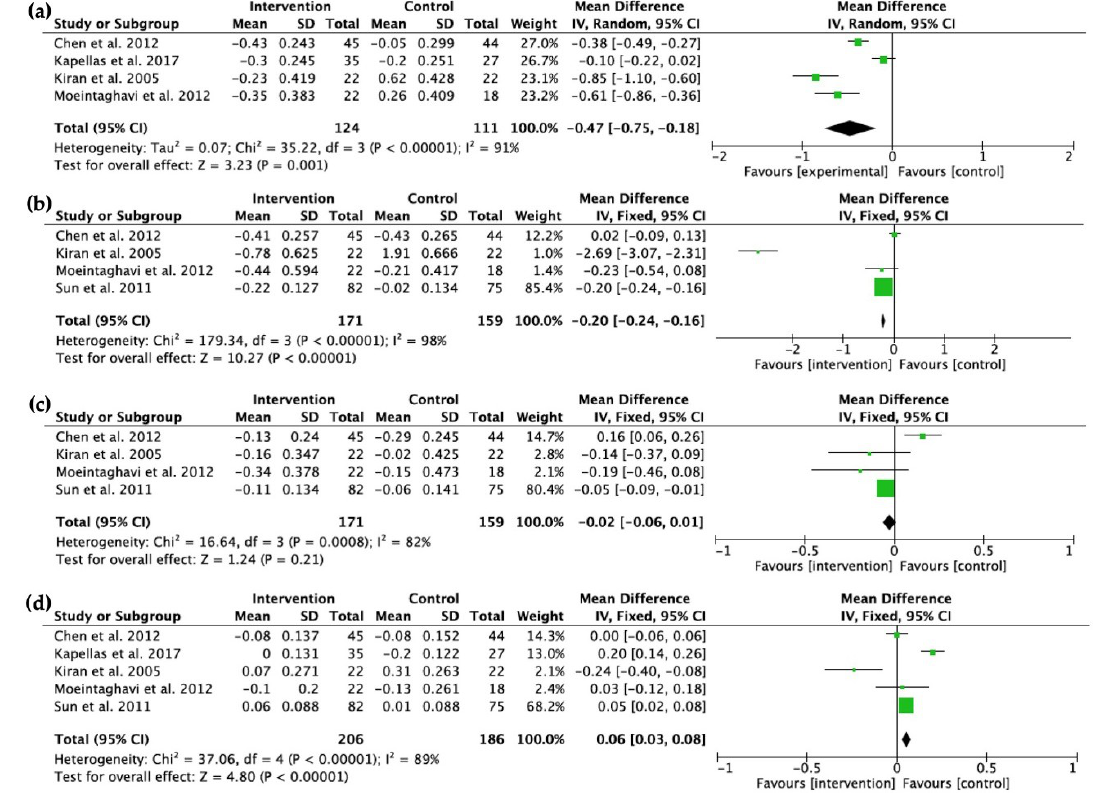
Figure3. Forestplotsdepictingthechangesof( a )totalcholesterol, ( b )triglycerides, ( c )LDL,and( d )HDL Figure 3. Forest plots depicting the changes of ( a ) total cholesterol, ( b ) triglycerides, ( c ) LDL, and ( d ) (all in mmol / L) between the intervention and control groups at baseline and the 3-month HDL (all in mmol/L) between the intervention and control groups at baseline and the 3-month follow- up.